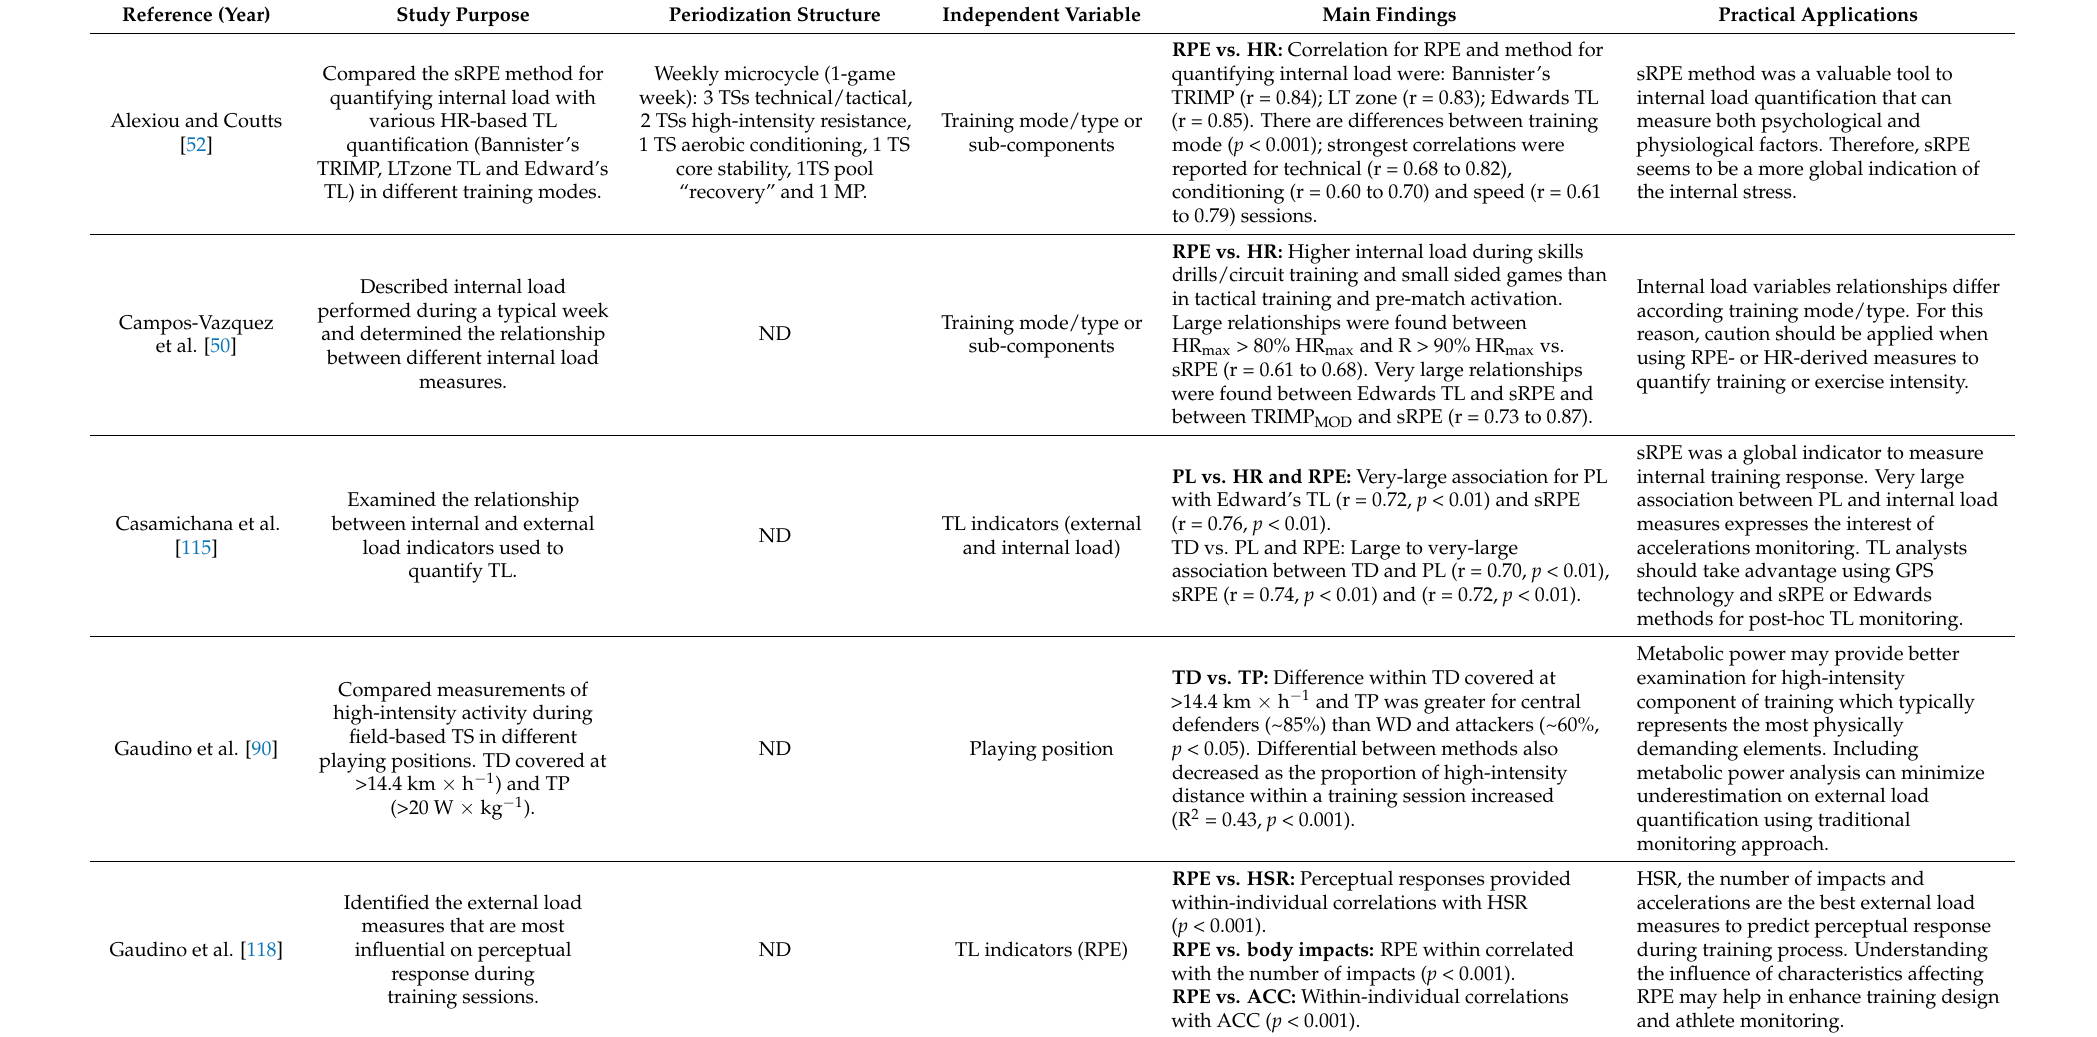
Table 7. Studies with predominant focus on the relationships between internal and external